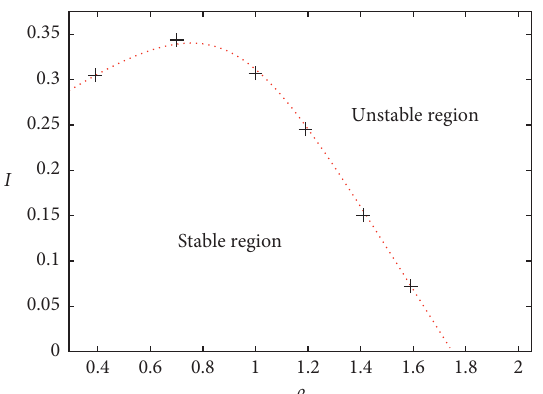
Figure 8: The Hopf bifurcation curves in the β − I plane for the analytical (red dotted line) and numerical simulation (black crosses).